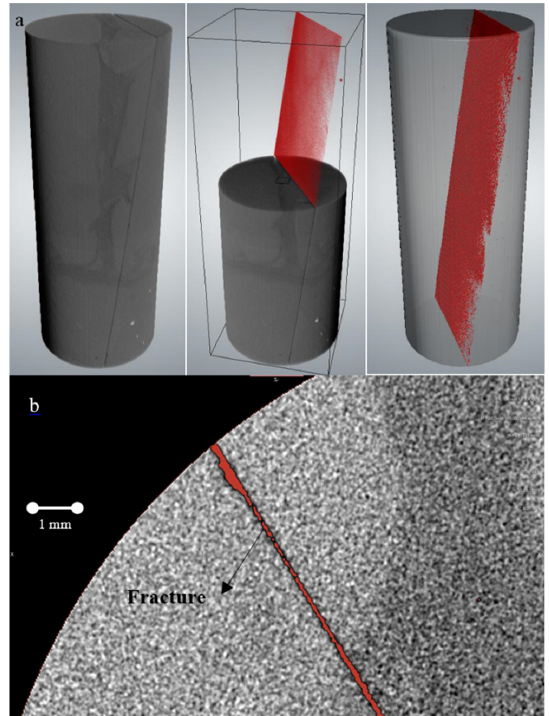
Figure 2. Micro-CT images illustrating ( a ) carbonate core and the fracture inside it and ( b ) micro-scale asperity on the surface of the fracture.